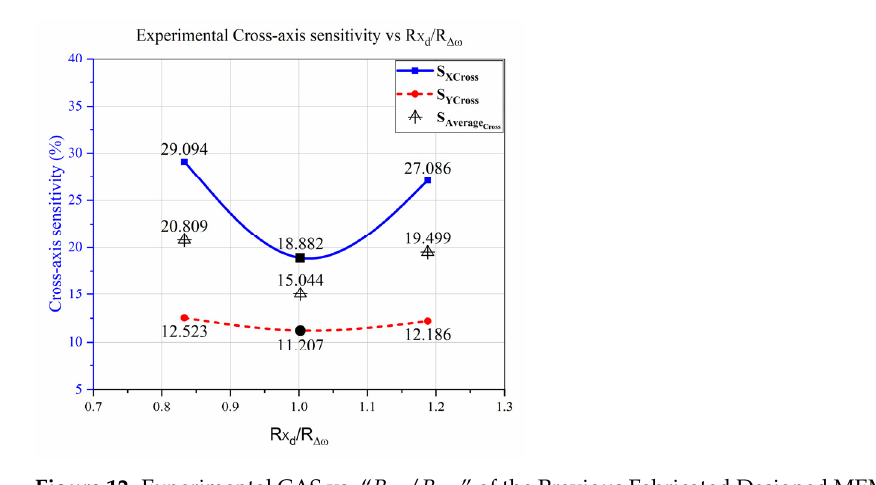
/ R ∆ ” of the Previous Fabricated Designed MEMS /𝑅 d ω ∆ 𝝎 ” of the Previous Fabricated Designed MEMS 𝒅